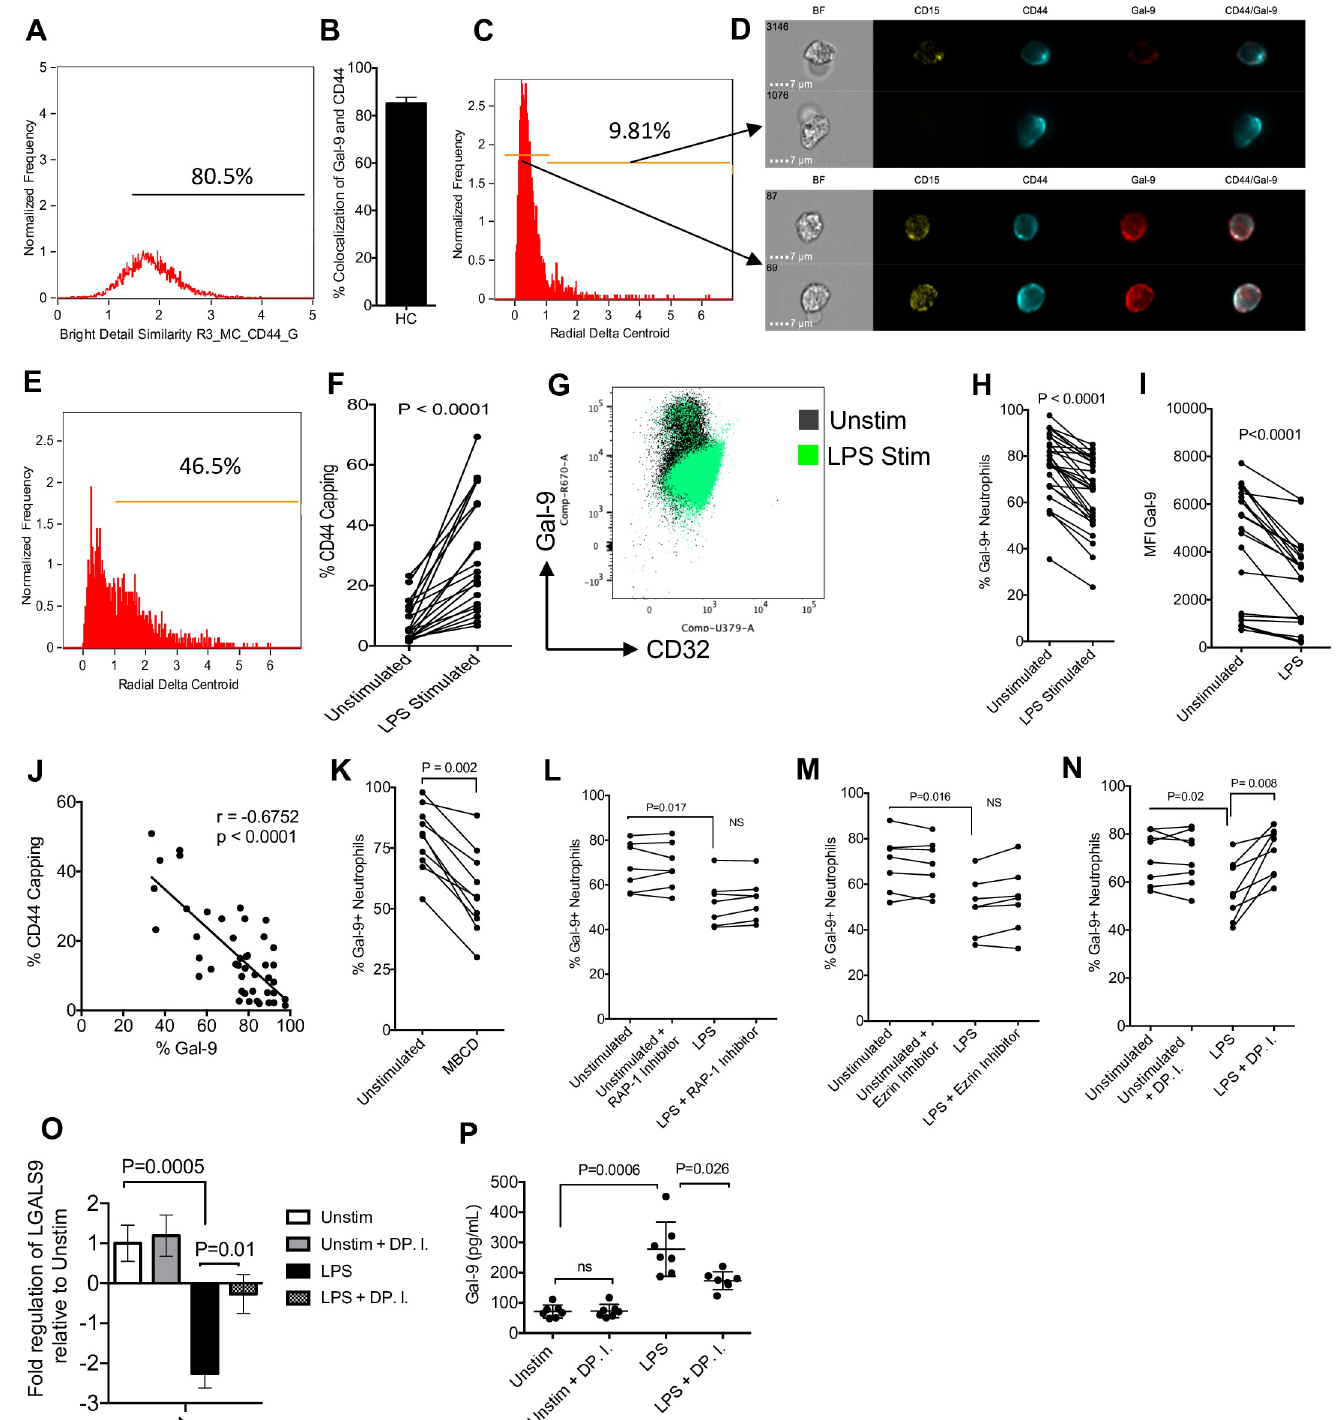
Fig 6. Gal-9 is shed by neutrophil mediated DP of CD44 upon activation. (A) Percent colocalization of CD44 and Gal-9 on neutrophils quantified using an Amnis ImageStream. (B) Cumulative percent colocalization of Gal-9 and CD44 on the surface of neutrophils. (C) Representative plot of neutrophils with a high and low delta centroid XY. (D) Representative images of capped and dispersed CD44 on neutrophils. (E) Representative plot of LPS-treated neutrophil radial delta centroid. (F) Cumulative data of CD44 capping (delta centroid > 1) in unstimulated and LPS-treated neutrophils. (G) Representative plot showing changing Gal-9 and CD32 expression on neutrophils untreated or stimulated with LPS. (H) Cumulative results showing the percent expression of surface Gal-9 on unstimulated and LPS stimulated neutrophils. (I) Cumulative results showing the MFI of surface Gal-9 on unstimulated and LPS stimulated neutrophils. (J) Cumulative data showing